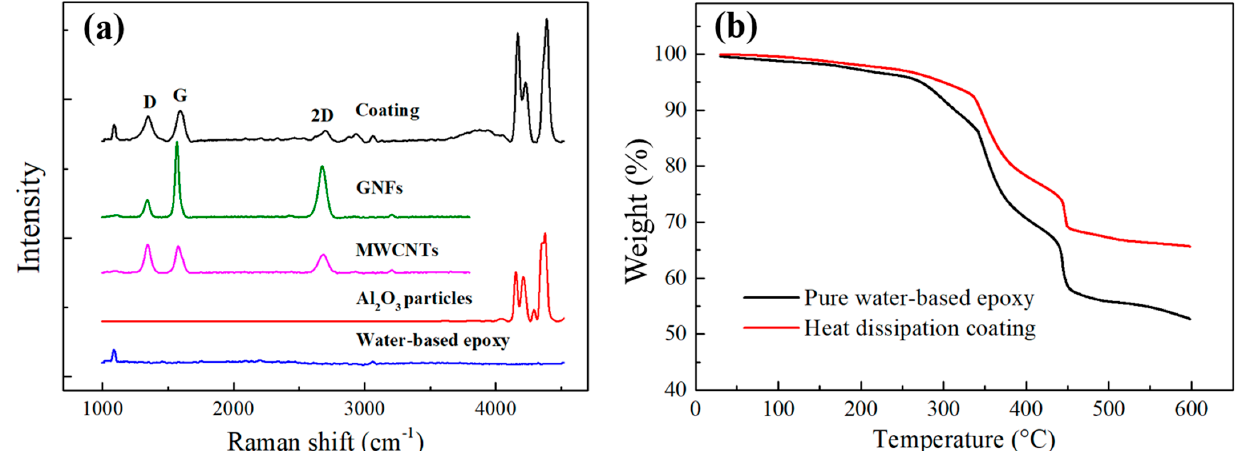
Figure 8. ( a ) Comparison of the Raman spectra for the different materials in coating; ( b ) TGA curves of the pure epoxy and heat dissipation coating.